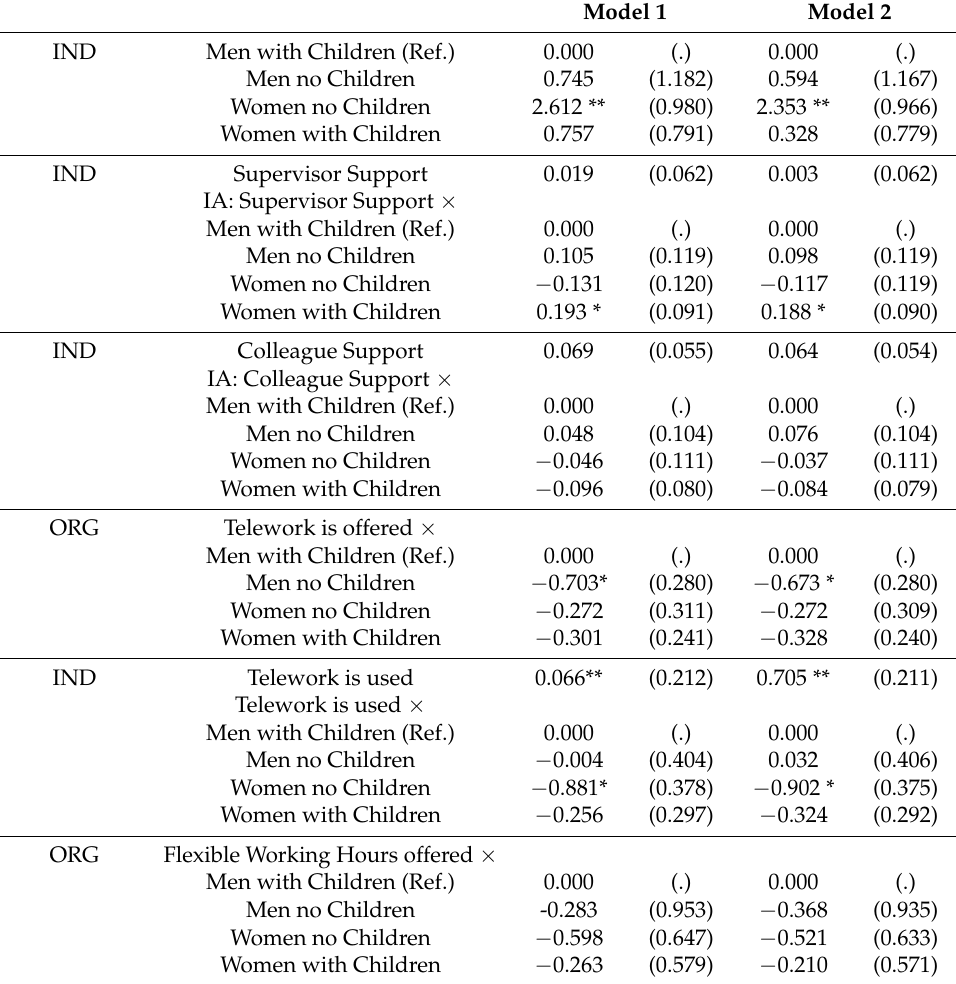
Table A1. Gender Gap in Claims-Making and Family-Friendliness of the Work Environment (results of logistic fixed-effects